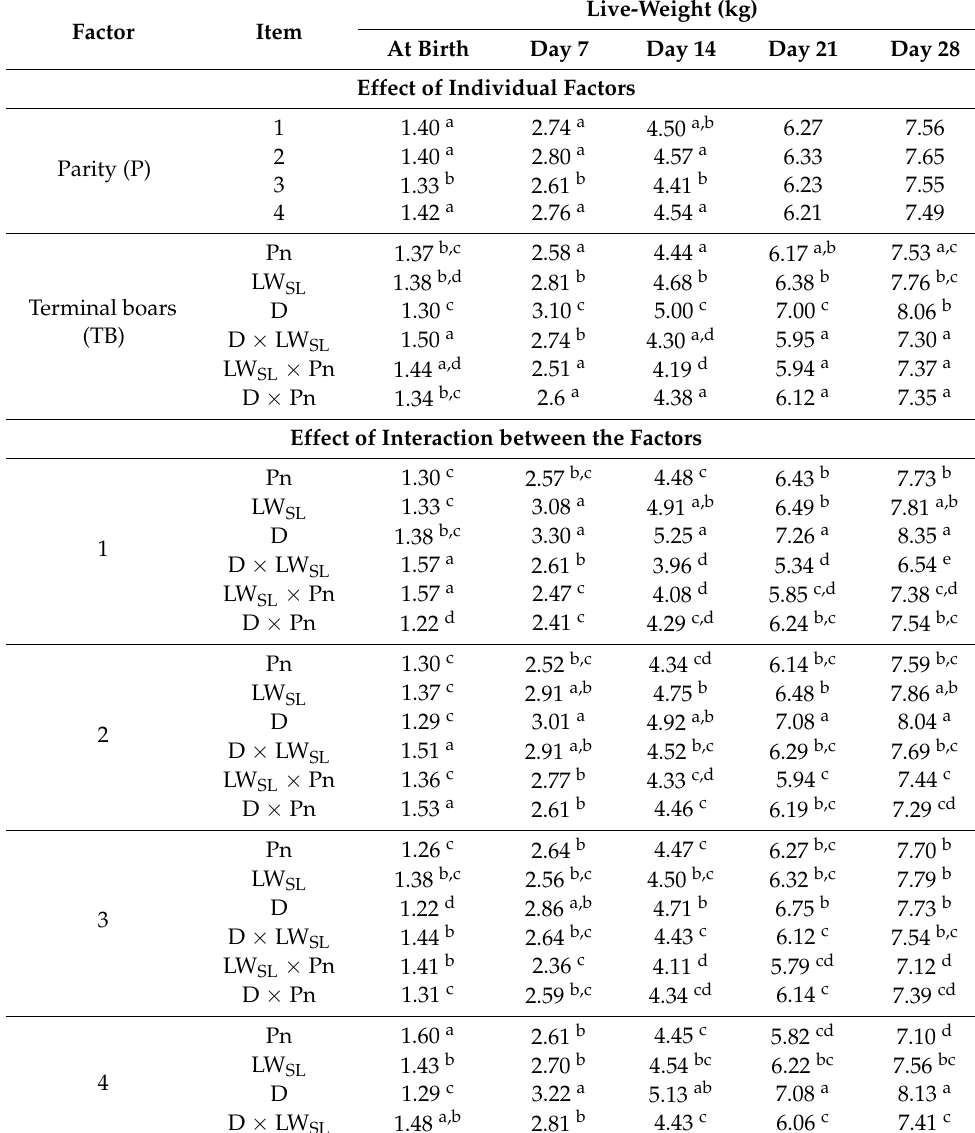
Table 5. The effect of terminal boar and parity of sows on individual weight of piglets. Live-Weight (kg) Factor Item At Birth Day 7 Effect of Individual